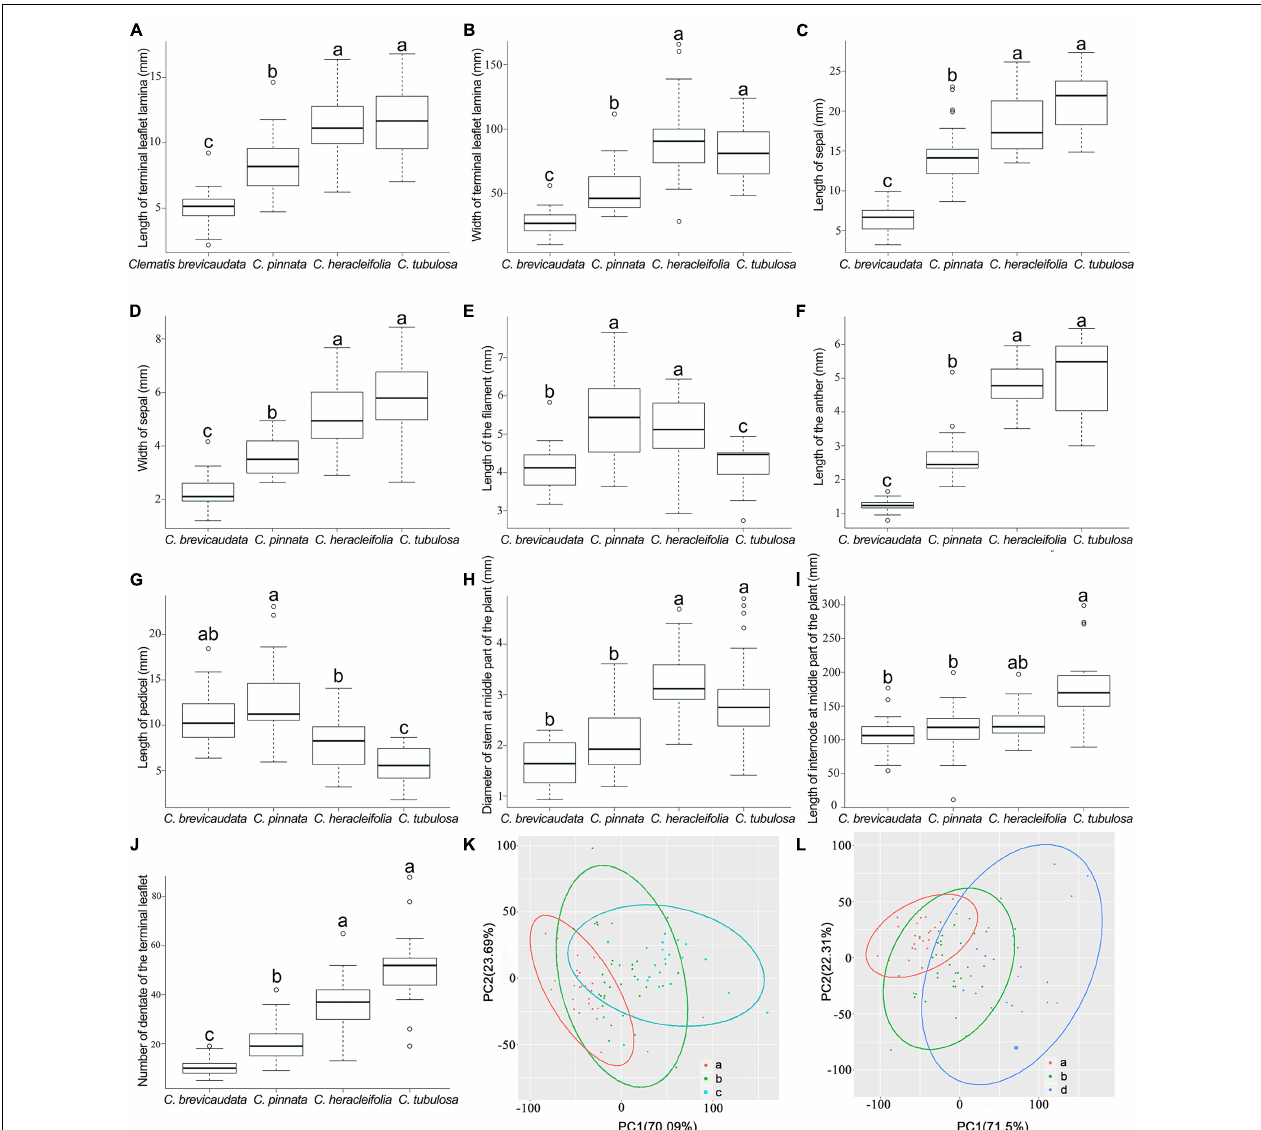
FIGURE 6 | Boxplots (A–J) and PCA plots (K,L) based on ten quantitative morphological characters of Clematis pinnata and its putative parents. (A–J) In each boxplot, groups sharing letters denote no significant difference between those groups, as identified by post hoc Tukey’s tests with false discovery rate corrections (Benjamini and Hochberg, 1995) for multiple comparisons. (K,L) Venn diagrams of PCA results show C. pinnata ’s (b, 29 specimens) quantitative characters are intermediate to either C. brevicaudata (a, 124 specimens) and C. heracleifolia (c, 56 specimens) or to C. brevicaudata and C. tubulosa (d, 69 specimens).